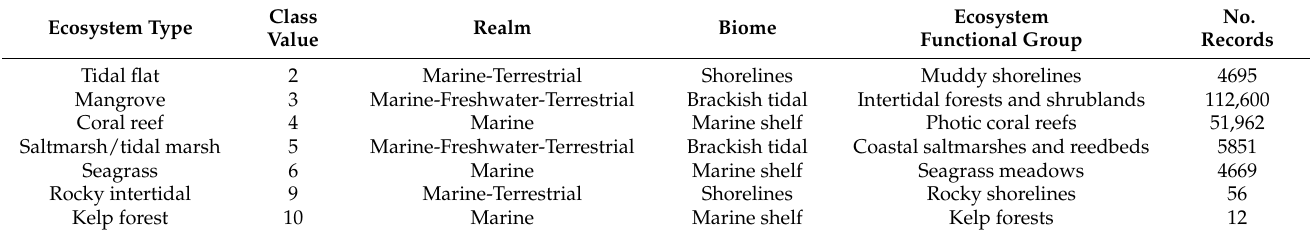
Table 1. Coastal ecosystem types included in the coastTrain dataset. Realm, biome and ecosystem functional group correspond to the IUCN Global Ecosystem Typology [5]. Although rocky shorelines and kelp forests are poorly represented in coastTrain v1.0 , we expect the number of records to grow with new submissions and expansions mapping programs over